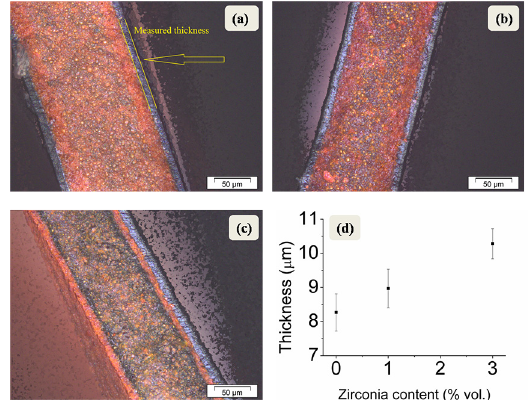
Figure 5. Optical microscopy images showing cross-sections of the different tapes after debinding: (a)Cu; (b)Cu-1Z; (c)Cu-3Z and; (d) thickness of the oxidation layer as function of zirconia content.